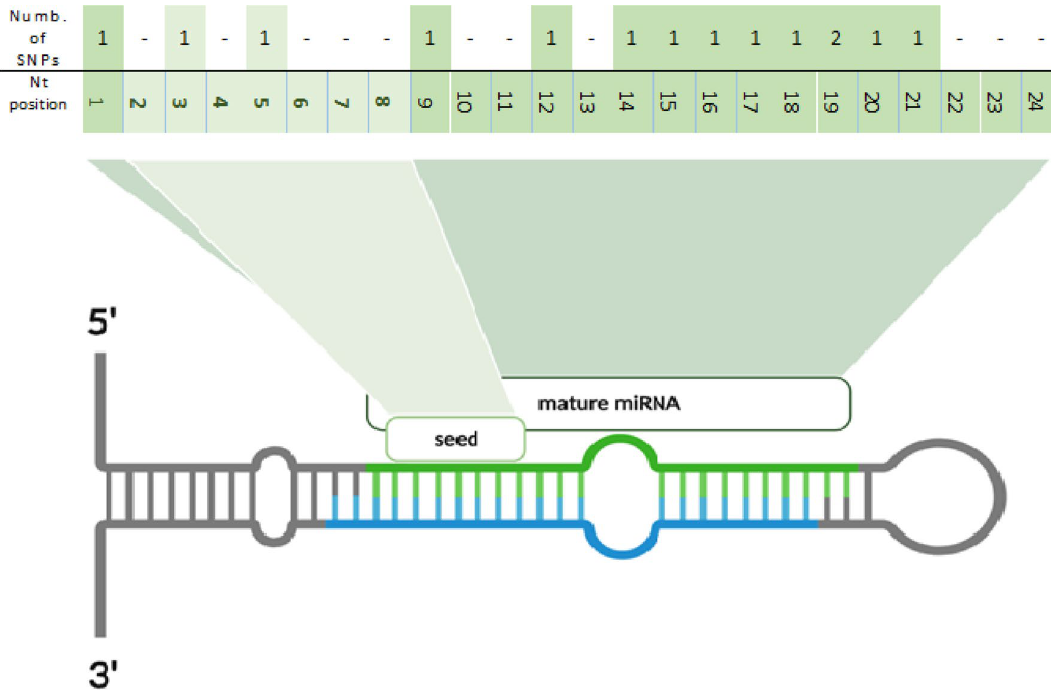
Figure 1. Distribution of the localization of all SNPs identified in mature miRNA sequences in this study. The upper row of the table contains data on the number of SNPs identified in a given position of the mature miRNA sequence, while the lower row indicates a nucleotide position of the mature miRNA sequence. The light green coloured cells stand for the positions of the seed nucleotides (2–8).